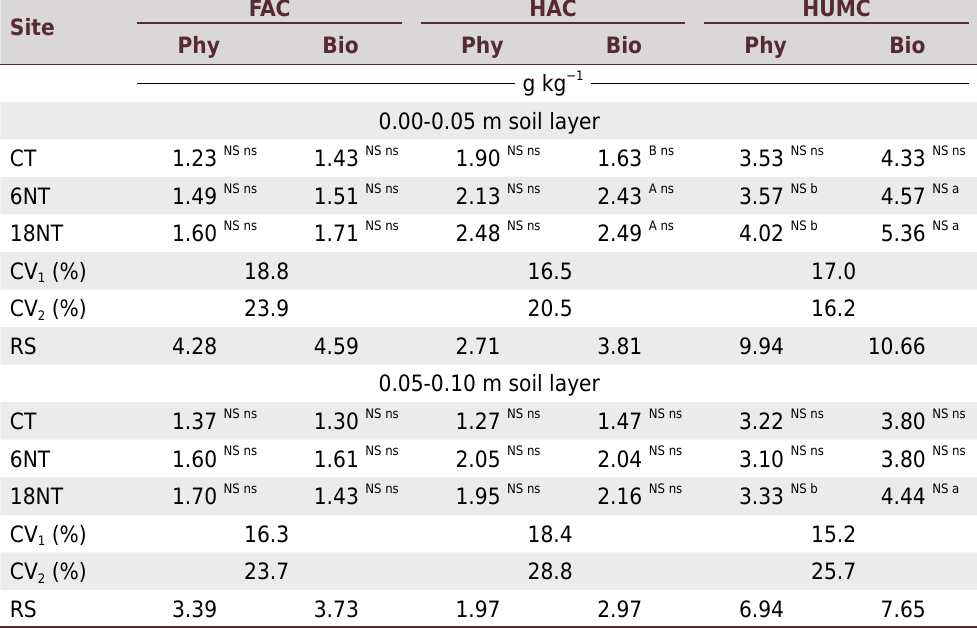
Table 1. Distribution of organic carbon in humic fractions of physicogenic (Phy) and biogenic (Bio) aggregates from 0.00-0.05 and 0.05-0.10 m depth soils under different management systems in the Cerrado region of Uberaba, Minas Gerais,